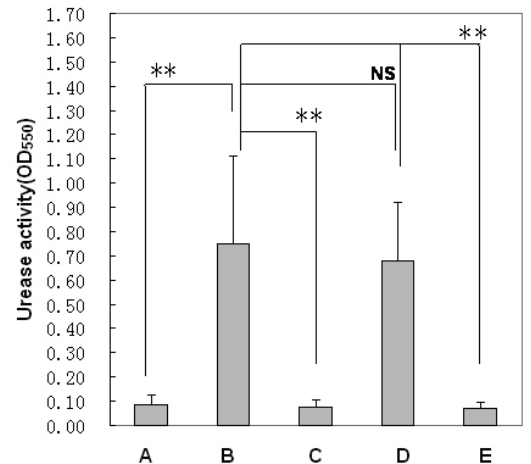
Figure 4. Evaluation of clearance efficiency of H. pylori infection based on urease activity tests. (A) The normal control mice; (B)The model mice of H. pylori infection; (C) The mice treated with pexiganan; (D) The mice treated with placebo nonaparticles (control); (E) The mice treated with PNPs. (** p < 0.01 and NS: no significant differences).